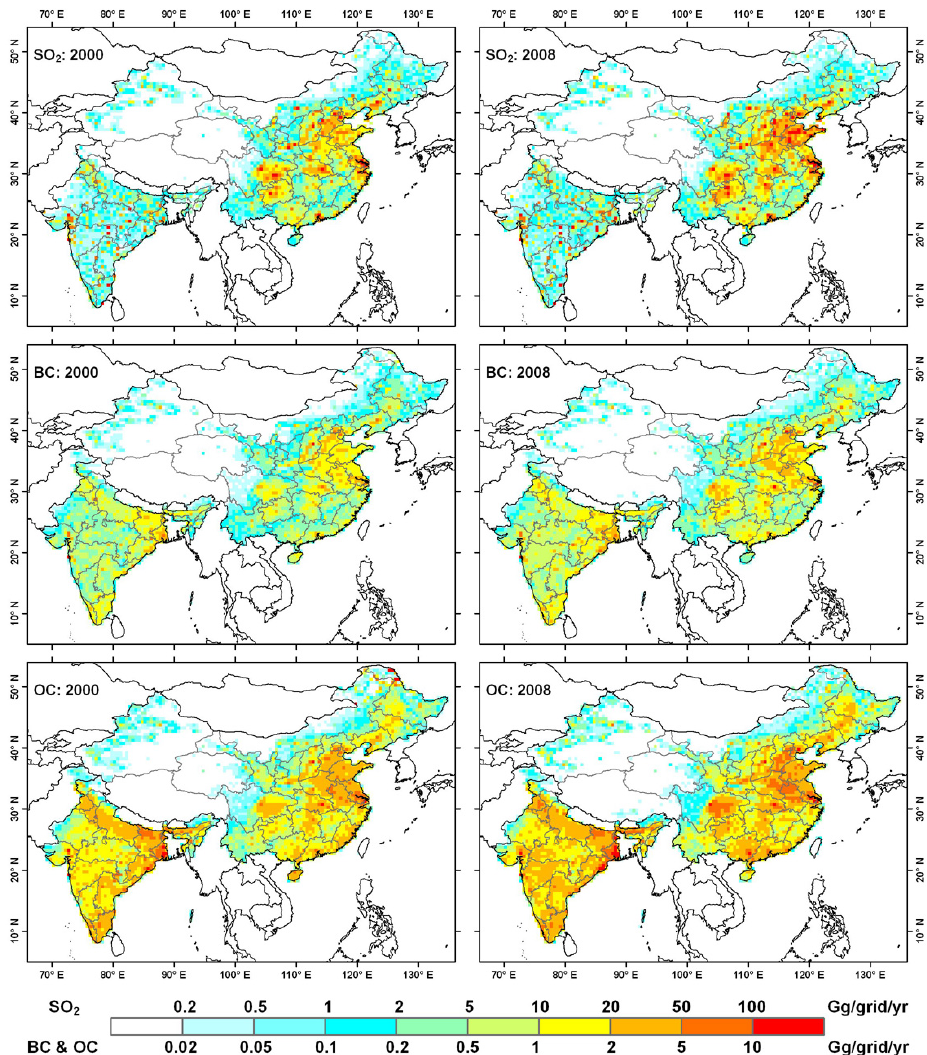
Fig. 8. Emission distributions of SO 2 , BC, and OC at 0.5 ◦ × 0.5 ◦ resolution in 2000 and 2008. International shipping and aviation are not